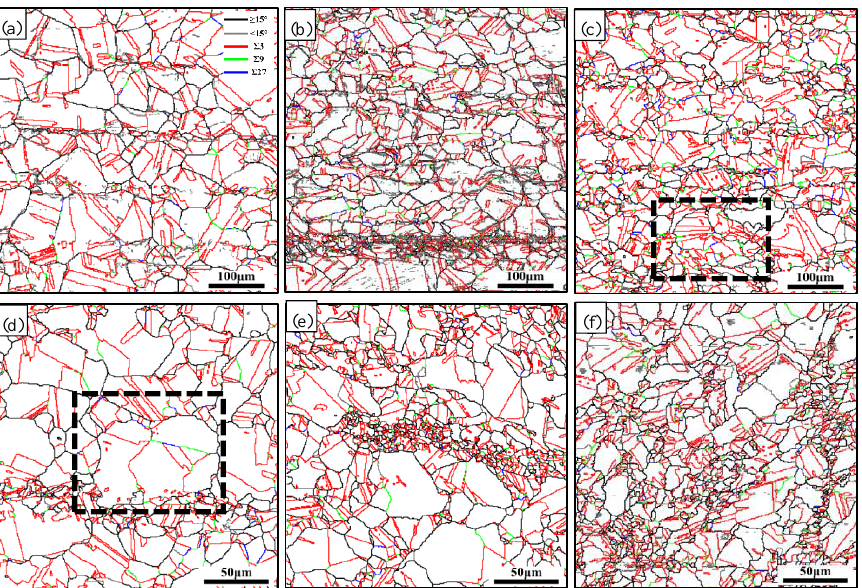
Figure 5. GBCD maps of C276 superalloy annealed at 1050 °C for 30 min with different cold rolling reductions. ( a ) 5%, ( b ) 10%, ( c ) 15%, ( d ) 20%, ( e ) 30%, ( f ) 40%.